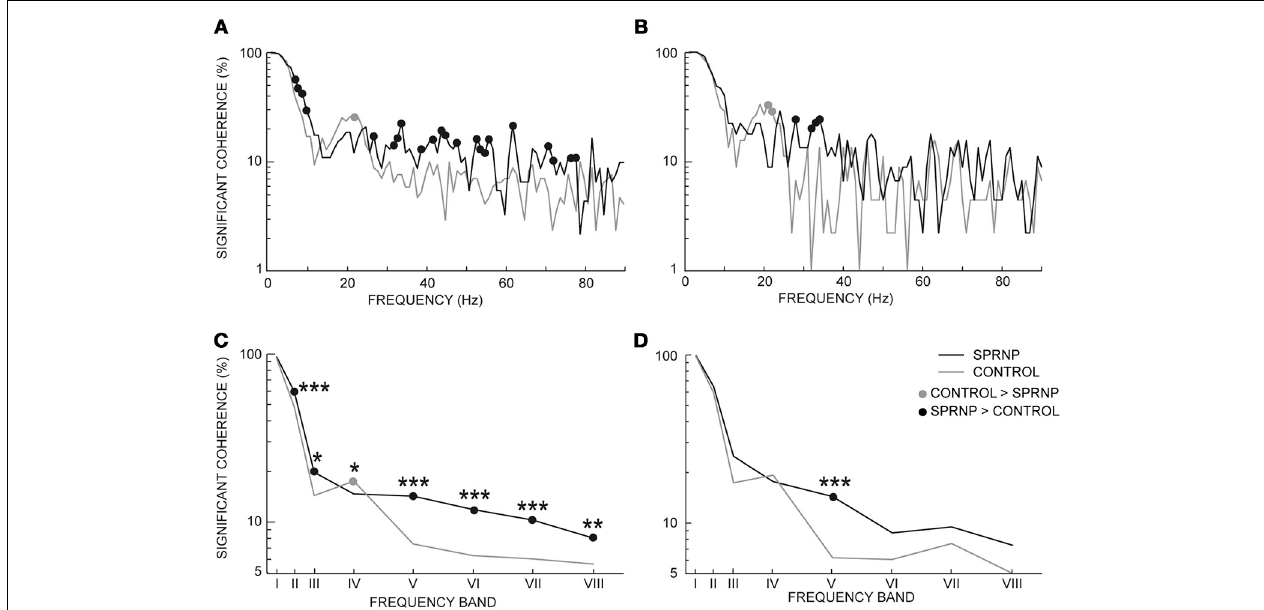
FIGURE 4 | Percentage of significant coherence values per 1Hz-bin from all MU pairs (A), and 45 pairs firing at similar frequencies for 2min (B); percentage of significant coherence values within 8 frequency bands for all Ms pairs (C), and the 45 pairs subsets (D); (C,D) abscissa median